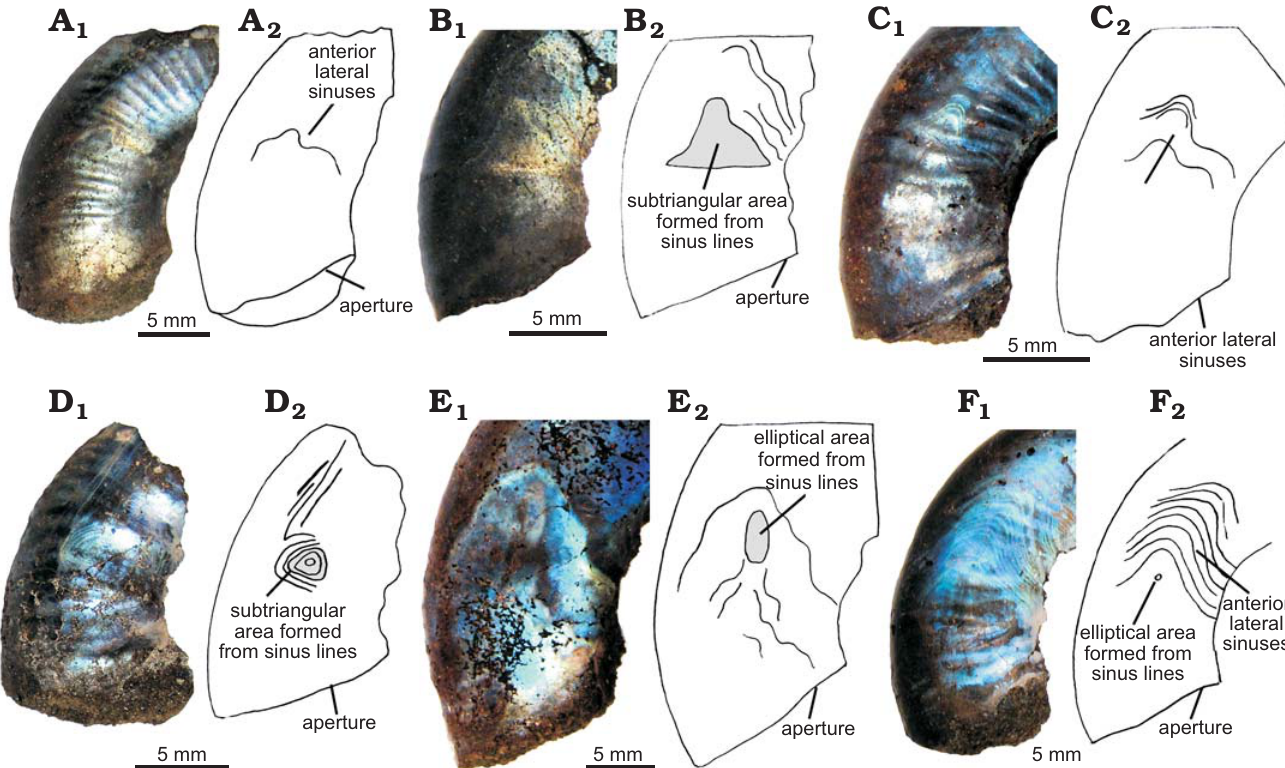
Fig. 11. Apertural parts of the anterior lateral sinuses of Kachpurites fulgens (Trautschold, 1861) from Late Volgian ( Kachpurites fulgens Zone), Moscow region, Eganovo locality (B) and Mnevniki locality (A, C–F). A . MSU 113/24, lateral sinus line in the apertural part of the body chamber. B . MSU 113/7 (see also Fig. 6B), apertural part of the body chamber with lateral sinuses. C . MSU 113/12 (see also Fig. 10B), lateral sinuses in the apertural part of the body chamber. D . MSU 113/23, apertural part of the body chamber with lateral sinuses. E . MSU 113/27, apertural part of the body chamber with a very bright lateral sinus. F . MSU 113/6 (see also Fig. 10C), apertural part of the body chamber. Apertural edge is not preserved. Photographs (A explanatory drawings (A –F 2 2